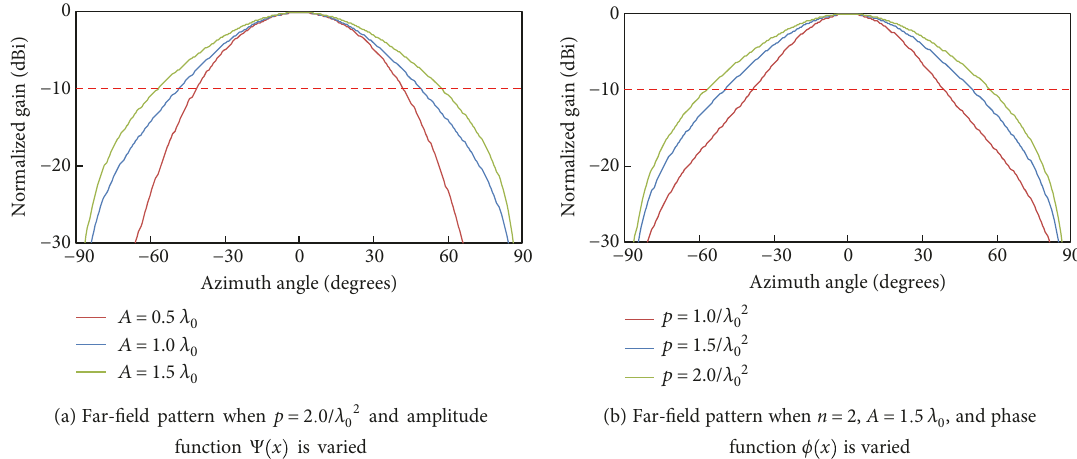
Figure 7: Normalized far- fi eld patterns calculated using approximated amplitude and phase shown in Figure